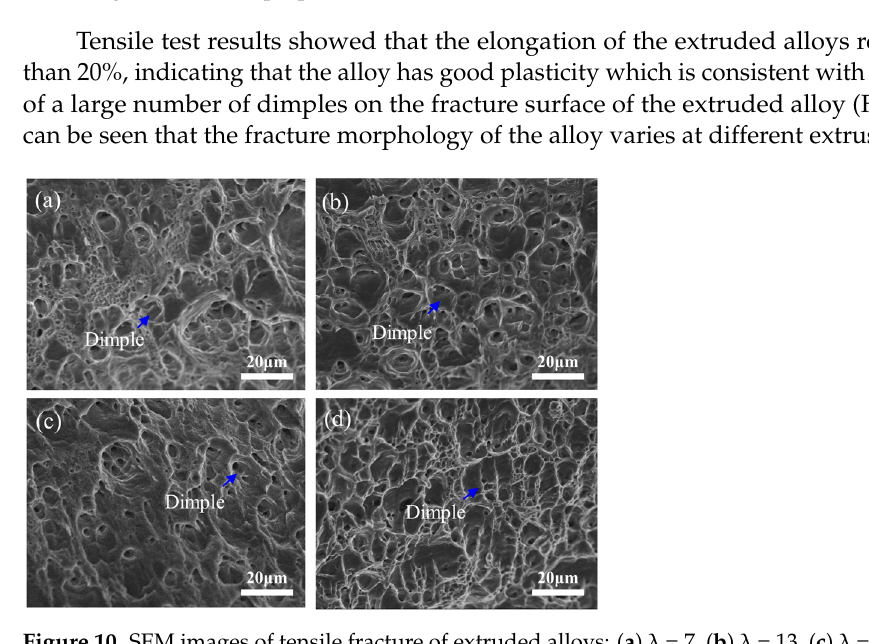
Figure 9. Effect of extrusion ratio on the tensile properties of the alloys: ( a ) Stress-strain curves; ( b ) Histogram of tensile properties.